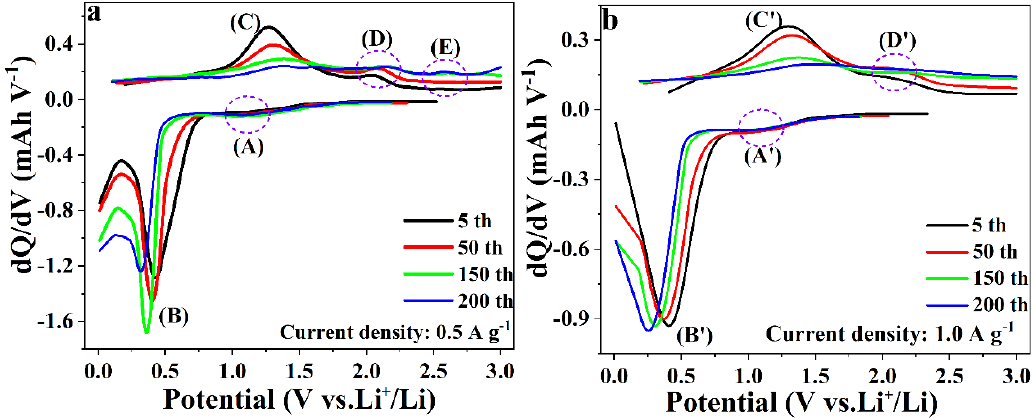
Figure 10. Differential capacities (dQ/dV) versus voltage plots of the charge and discharge curves for the current density 0.5 A g − 1 ( a ) and 1.0 A g − 1 ( b ) for MC-180. the current density 0.5 A g − 1 ( a ) and 1.0 A g − 1 ( b ) for